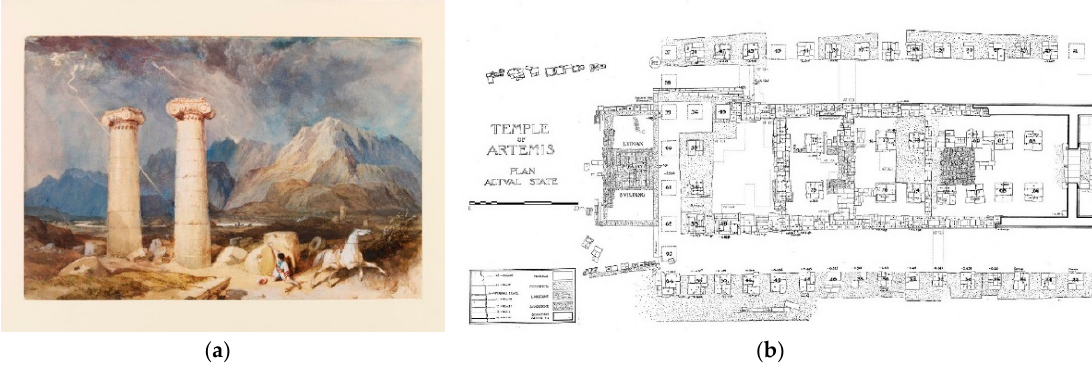
Figure 1. Illustrations of Sardis. ( a ) Title: Sardis. One of the Seven Churches (Watercolour), Date: 1834–1835, Place: Turkey, Artist/maker: Stanfield, Clarkson, Current Location: the Victoria and Albert Museum (used by permission); ( b ) Image Courtesy: Plan of the Temple of Artemis showing Church M. The Archaeological Exploration of Sardis/President and Fellows of Harvard College (used by permission).